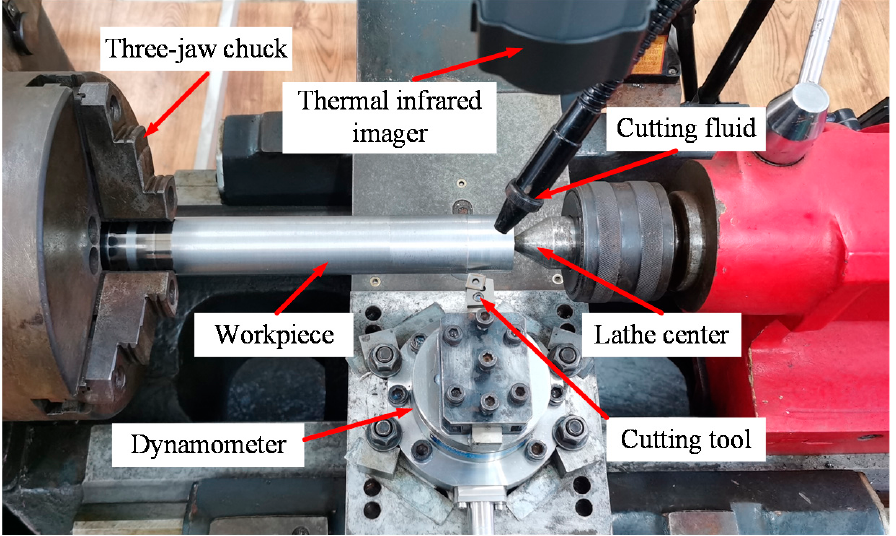
Figure 1. Photographic view of turning experiment.